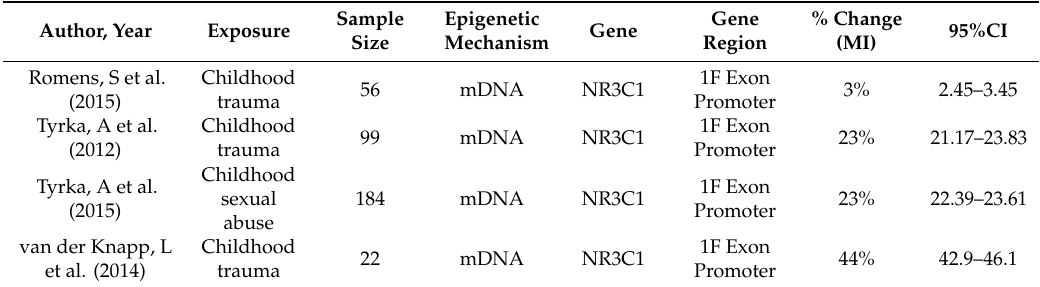
Table 2. DNA Methylation of NR3C1 in Social Adversity.